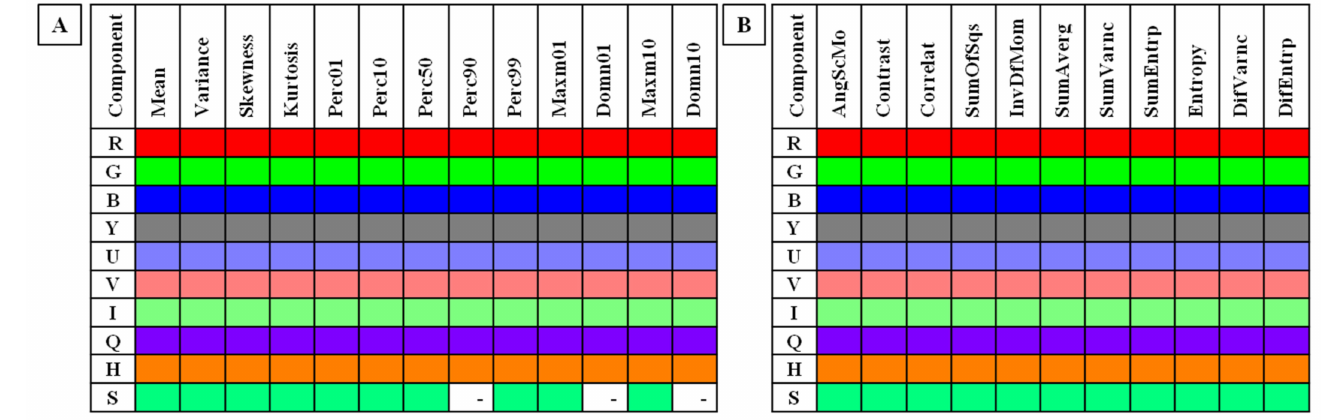
Figure 2. Features of ( A ) Histogram Statistics and ( B ) Gray Level Co-occurrence Matrix for each examined color component found not to be significantly different between months in the non-pregnant group. R—Red component in the RGB color model; G—Green component in the RGB color model; B—Blue component in the RGB color model; Y—Brightness component in the YUV/YIQ/HSB color models; U—U-component in the YUV color model; V—V-component in the YUV color model; I—I-component in the YIQ color model; Q—Q-component in the YIQ color model; H—Hue component in the HSB color model; S—Saturation component in the HSB color model. Skewness—skewness coefficient; Perc01, Perc10, Perc50, Perc90, Perc99—percentiles; Domn01, Domn10—dominants; Maxm01, Maxm10—maximum of moments; AngScMom—angular second moment/energy; Correlat—correlation; SumOfSqs—sum of squares; InvDefMom—inverse different moment/homogeneity; SumAverg—summation mean; SumVarnc—summation variance; SumEntrp— summation entropy; DifVarnc—differential variance; DifEntrp—differential